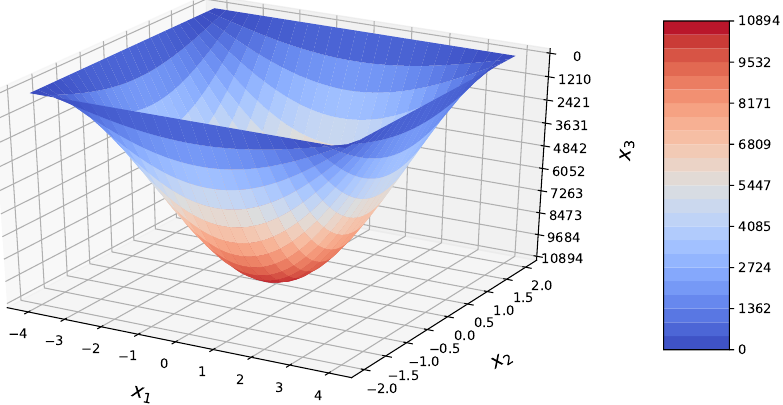
Figure 15. Three-dimensional plot of the bending moment M 22 of simply supported rectangular plate. Figures 16–18 show cross-sectional plots of deflections and moments.